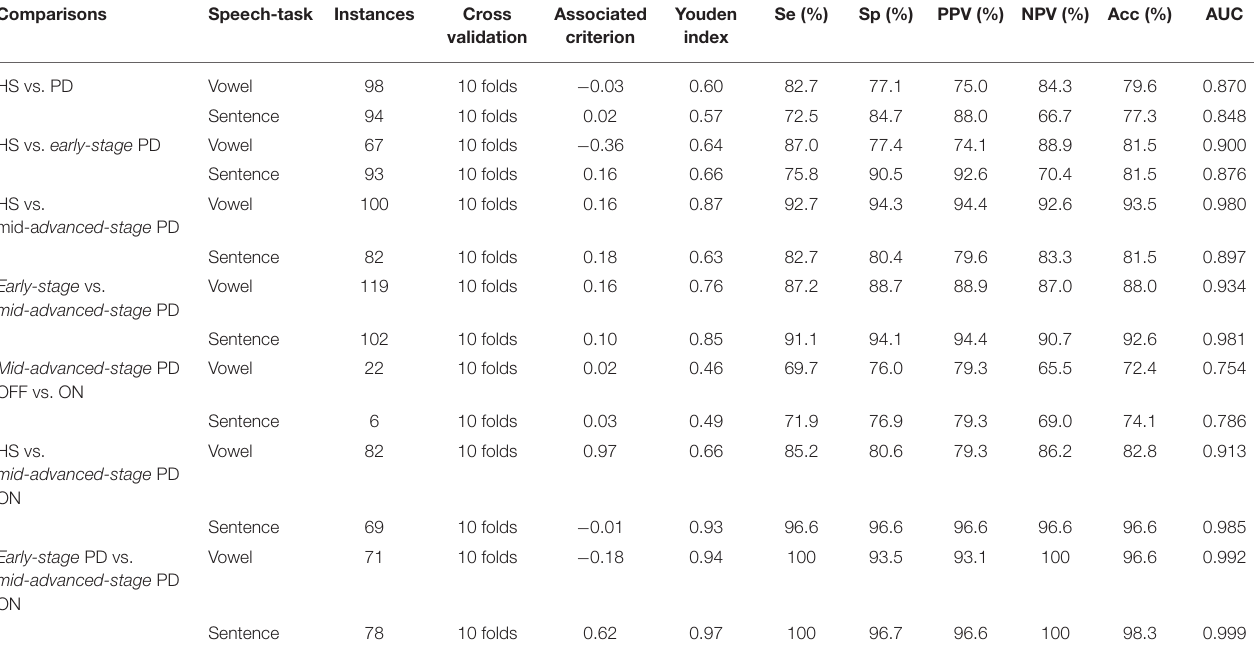
TABLE 3 | Performance of the machine learning algorithm.